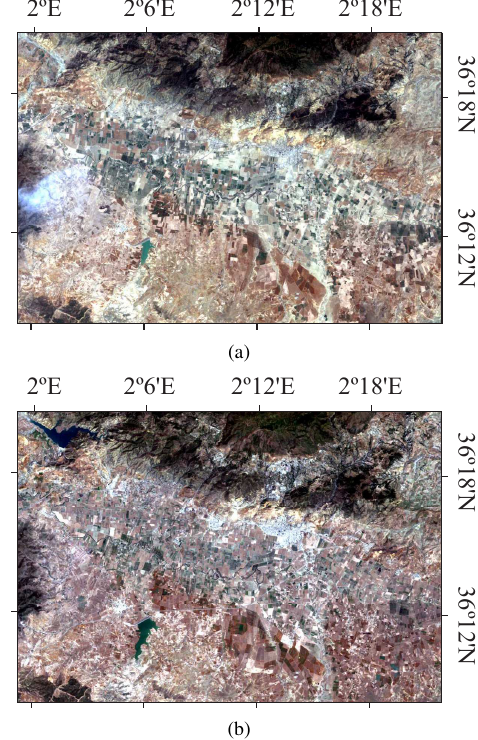
Figure 3: The studied area of Algeria: image acquired on June 14, 2002 in a), and image acquired on June 04, 2010 in b). vector is given by the following